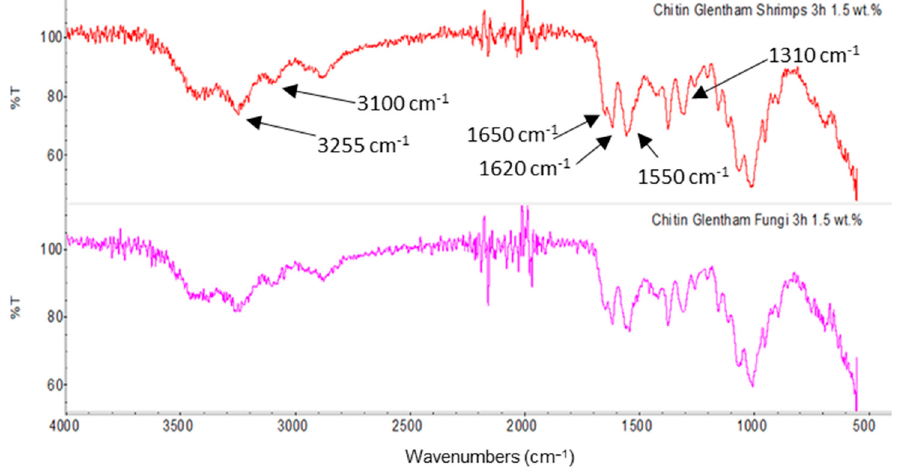
Figure 3. Comparison between ATR-IR spectra of chitin produced by shrimp and fungi. Table 5. Surface analysis of PBSA/PHBV films coated with chitin from fungi.